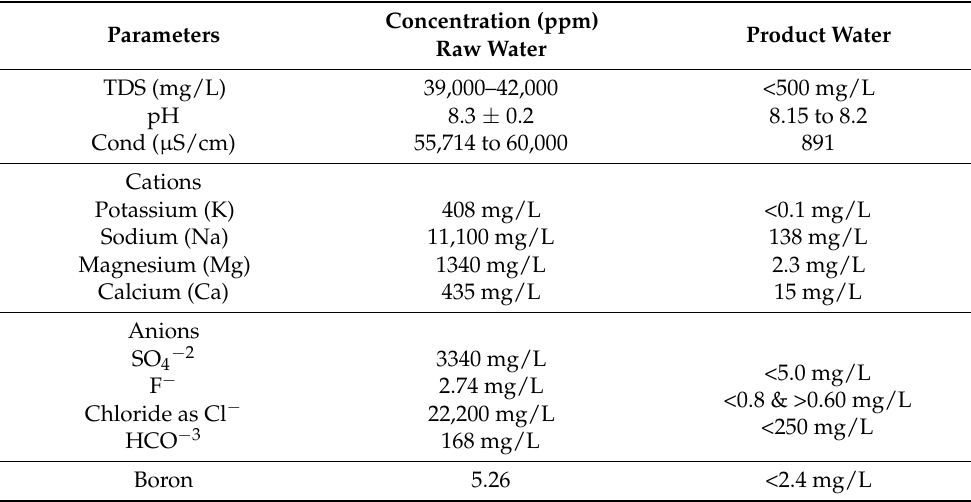
Table 1. Seawater and product characteristics of Barka desalination plant.